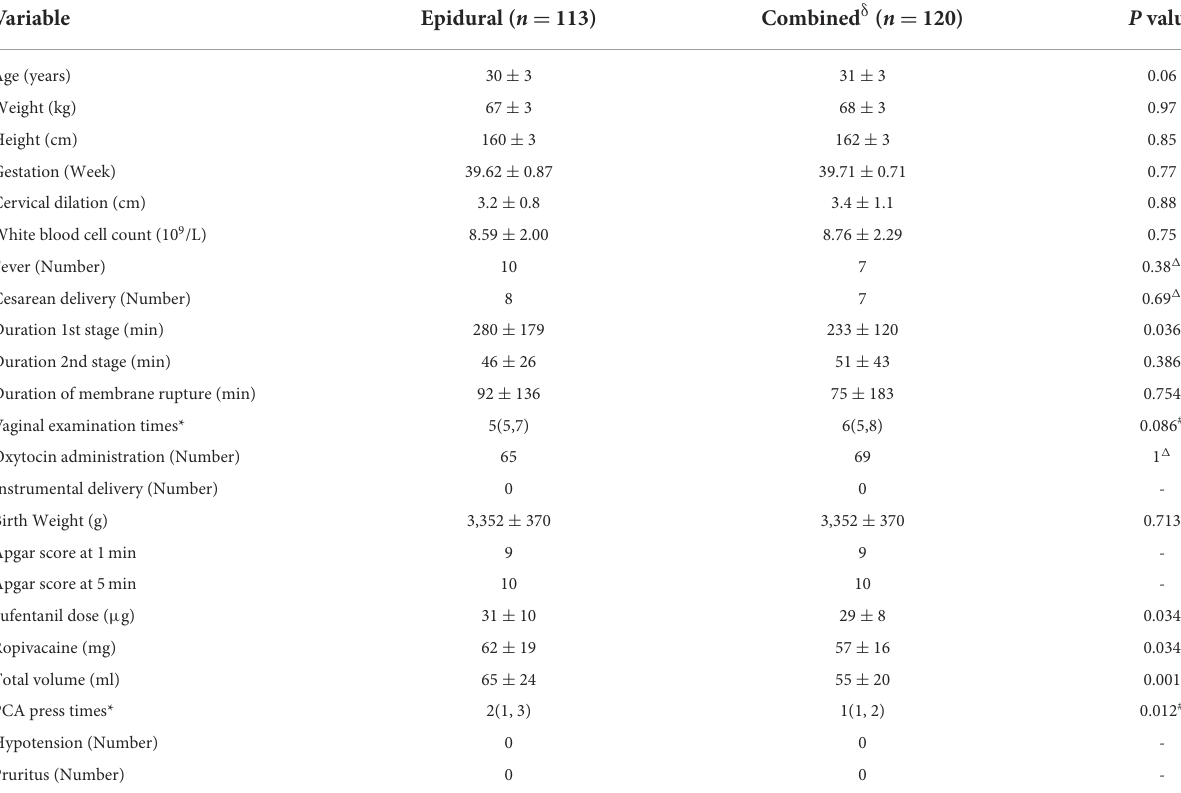
TABLE 1 Characteristics of all the parturients at admission and the delivery outcomes after labor.